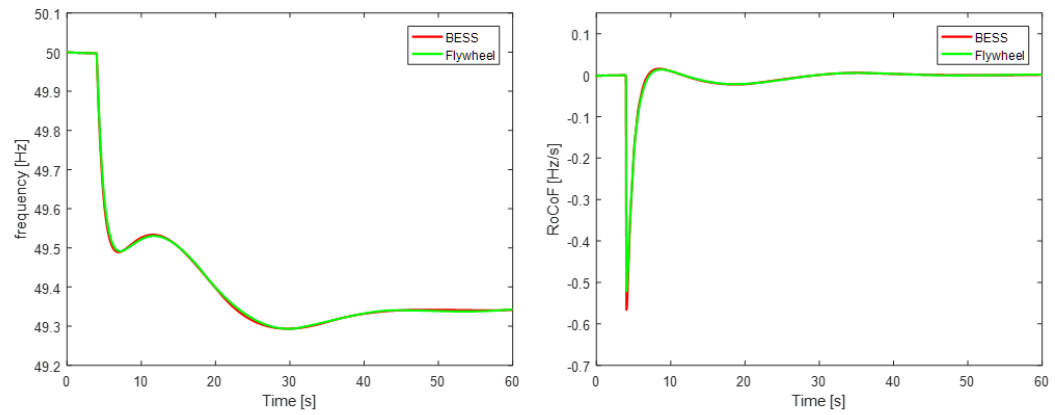
Figure 19. Frequency response and RoCoF for reference, future and future with BESS cases.